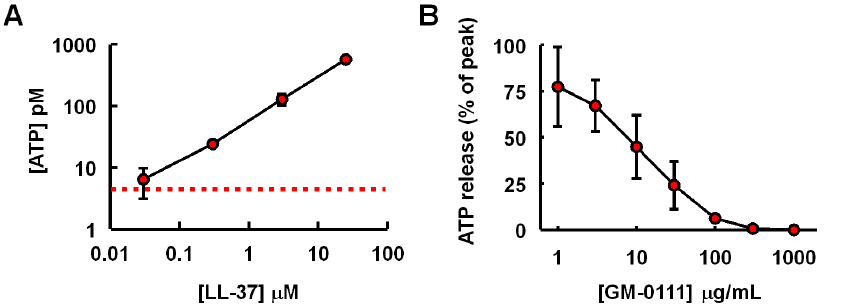
Figure 4. LL-37 induces ATP release from human urothelial cells (HUCs) (A) and GM-0111 reduces LL-37 induced ATP release in a dose-dependent manner (B). HUCs were challenged with LL-37 at various concentrations for 15 min and the culture supernatants were analyzed for ATP. To determine the inhibitory effects of GM-0111 against LL-37 induced ATP release, HUCs were treated with GM-0111 for 30 min prior to the 15 min LL-37 challenge (3 m M). Dotted red line indicates the basal concentration of ATP in the cell culture